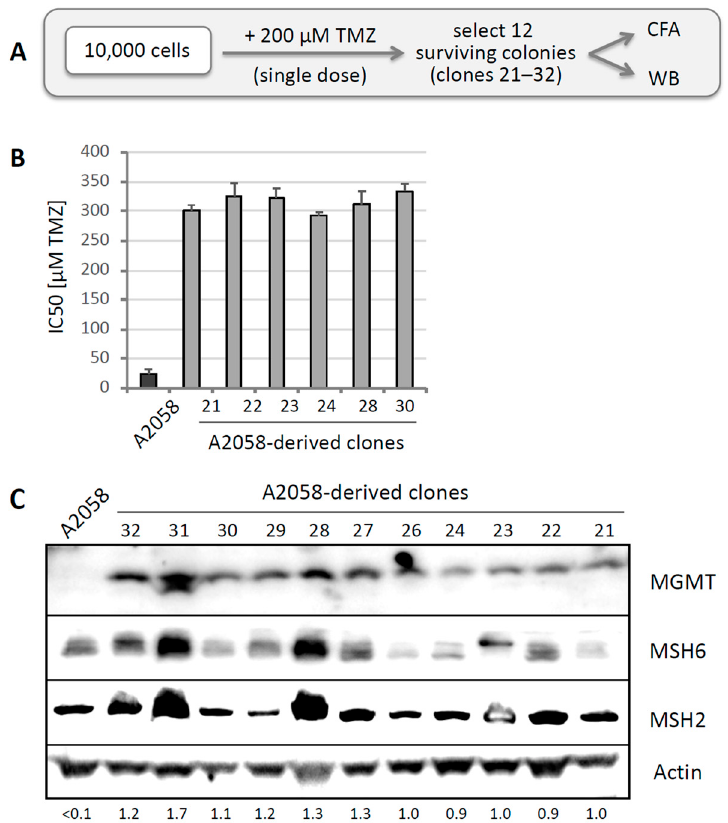
Figure 3. Selection of A2058 clones after high-dose TMZ treatment. ( A ) Treatment schedule was as follows: 10 5 A2058 cells (MGMT negative) were seeded into a 10-cm dish and treated with a single dose of 200 µ M TMZ for 48 h. Two weeks later, well over a thousand colonies emerged. To enable selection of well-isolated, individual clones, the colonies were pooled and re-seeded at very low density and allowed to form colonies again (in the absence of any further drug treatment). Then, 12 random colonies (numbered 21 through 32) were picked for further analysis by WB and CFA. ( B ) Six of these clones were subjected to CFA with increasing concentrations of TMZ. Shown is the average IC50 of each clone, in comparison to parental A2058 cells (left bar in black) ( n = 2–5, ± SE). ( C ) Eleven of these cell clones were lysed, and MGMT protein levels were analyzed by WB with actin as the loading control. Left lane shows lysate from parental A2058 cells. Numbers under the blot indicate quantification of MGMT bands, with reference to the actin signal, and relative to Clone 21 (right lane, set at 1.0); <0.1 indicates below detection limit.